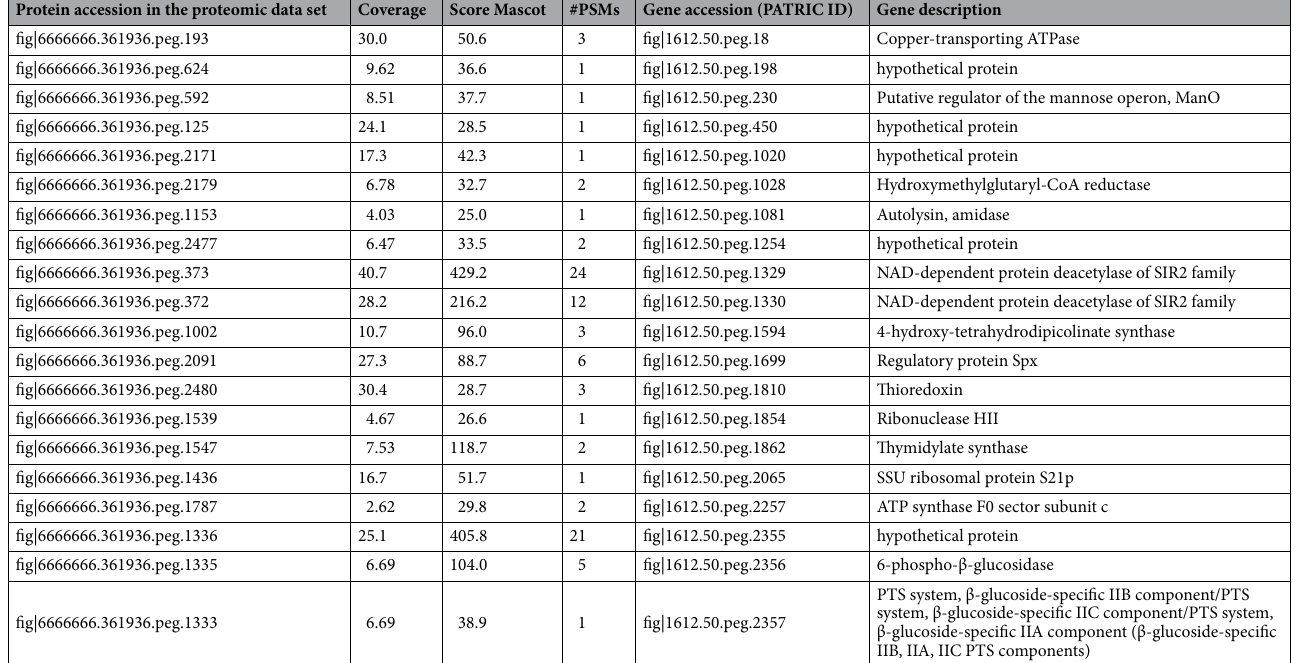
Table 1. Proteins detected only in induced cells of Companilactobacillus farciminis KB1089. The data were filtered with cut-offs Score Mascot > 0 and q-value ≤ 0.01, corresponding to a 1% false discovery rate on a spectral level. Protein accession numbers are available in the data set deposited in jPOST with accession number PXD011820. The numbers of peptides spectrum matches (#PSMs) reflect approximate amounts of detected proteins. Gene accession numbers corresponded to the detected proteins are available in database provided by the Pathosystems Resource Integration Center (PATRIC). The genes with PATRIC IDs fig|1612.50. peg.2355, fig|1612.50.peg.2356 and fig|1612.50.peg.2357 are selected as candidates.